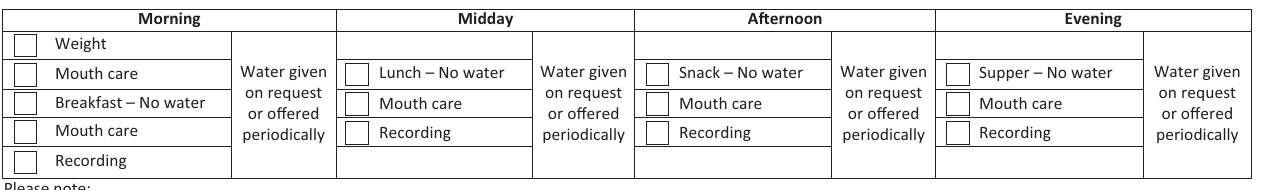
FIGURE 1: Mouth care and water provision schedule followed for the study